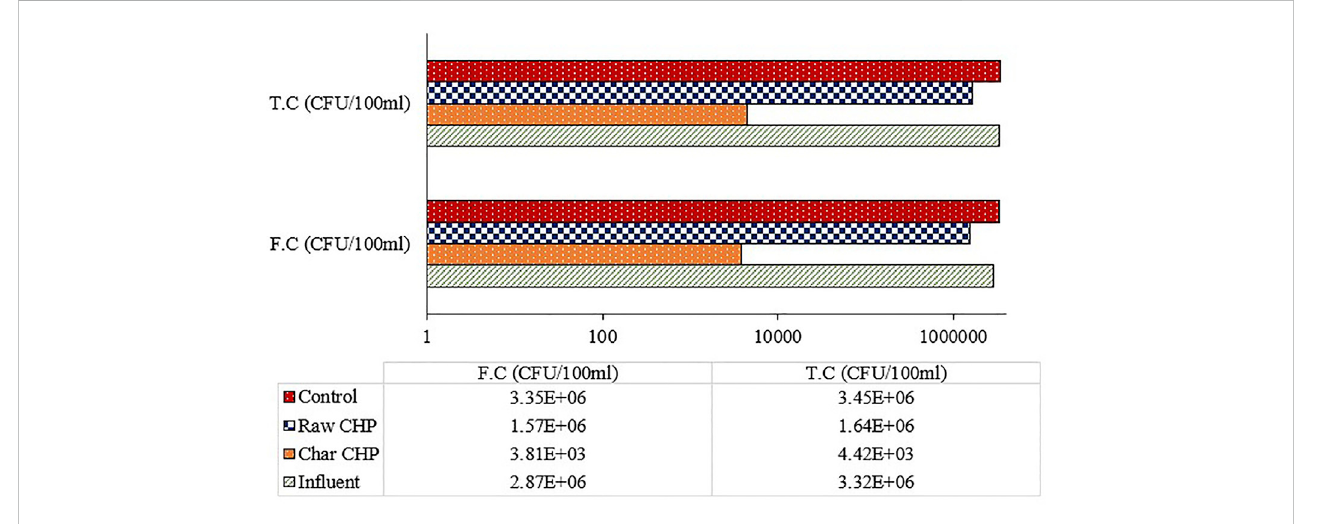
FIGURE 8 Microbial population of treated ef fl